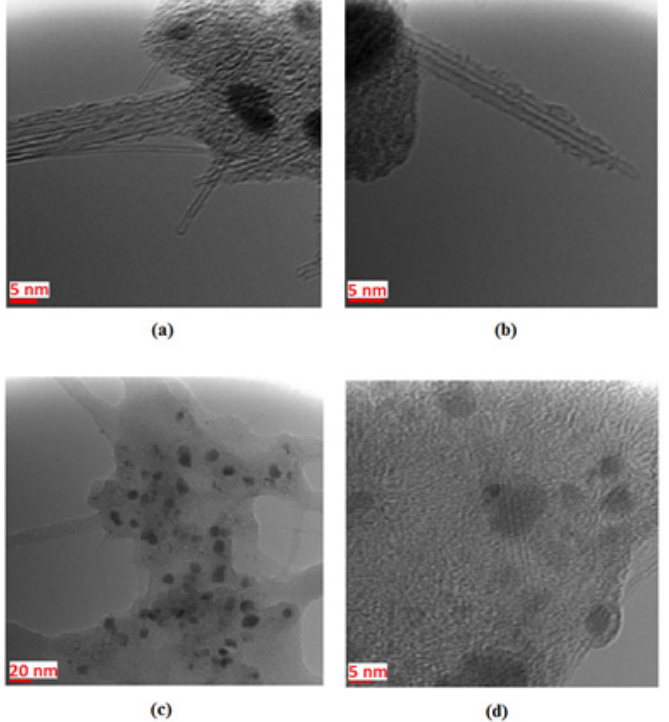
Figure 7. TEM pictures of OVK/SWCNT composites dispersed in chloroform ( a , b ) and in chlorobenzene ( c , d ) [18].